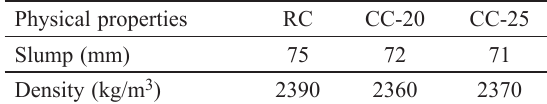
Table 3. Physical properties of the